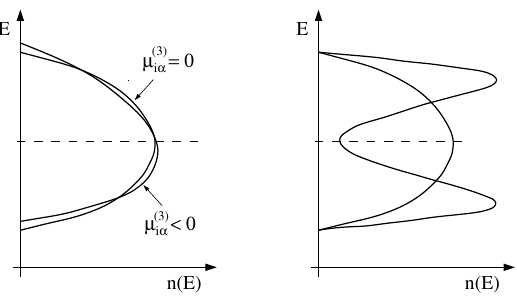
Figure 1. The third and fourth moment gives rise to a skewing ( left ) and a bimodal shape ( right ) of the DOS.